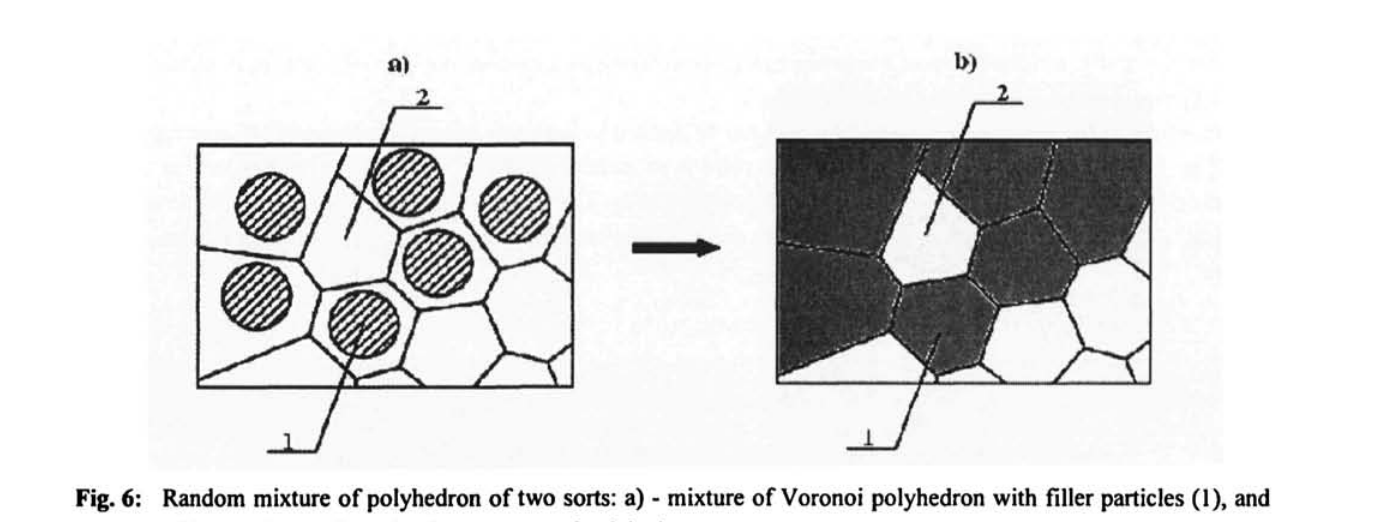
Fig. 6: Random mixture of polyhedron of two sorts: a) - mixture of Voronoi polyhedron with filler particles (1), and without filler particles (2); b) - mixture of polyhedron.